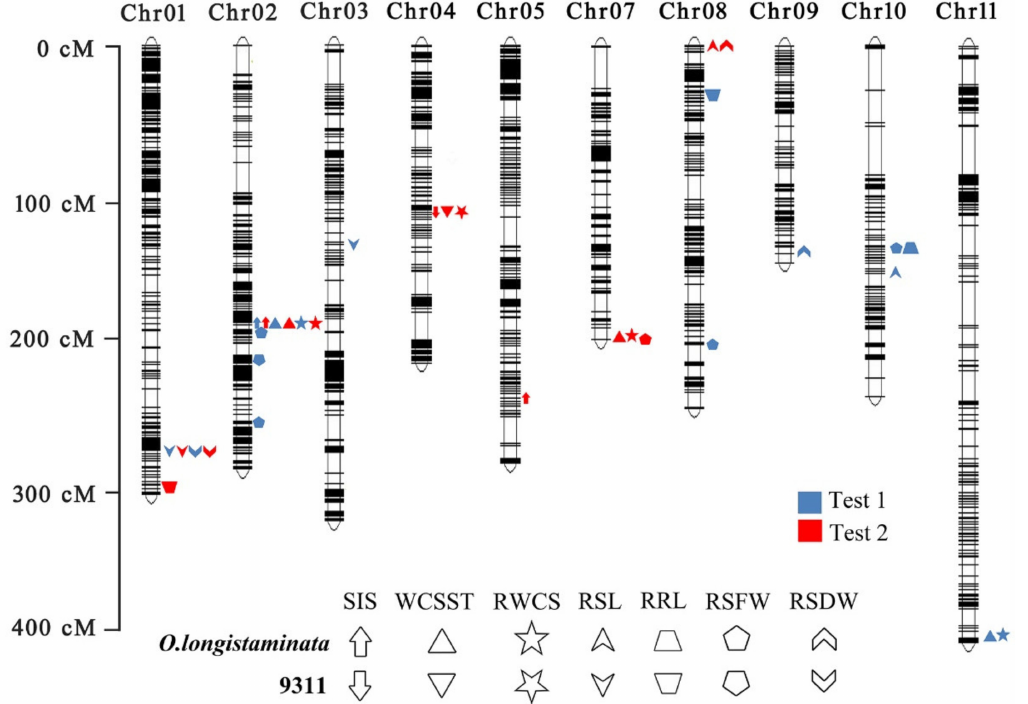
Figure 3. QTLs identified in the O. longistaminata for salt tolerance. Left is the scale for the genetic length of each chromosome. The upward direction indicates the locus comes from O. longistaminata , while the downward direction indicates the locus comes from 9311. The blue indicates QTLs detected in the first experiment and the red indicates QTLs detected in the second experiment. cM, centi-Morgan. Additionally, there were nine QTLs, including qRSL1 , qRSDW1 , qSIS4 , qWCSST4 , qRWCS4, qRSL3 , qRSFW2.2 , qRRL1 , and qRRL8 , for salt tolerance identified from